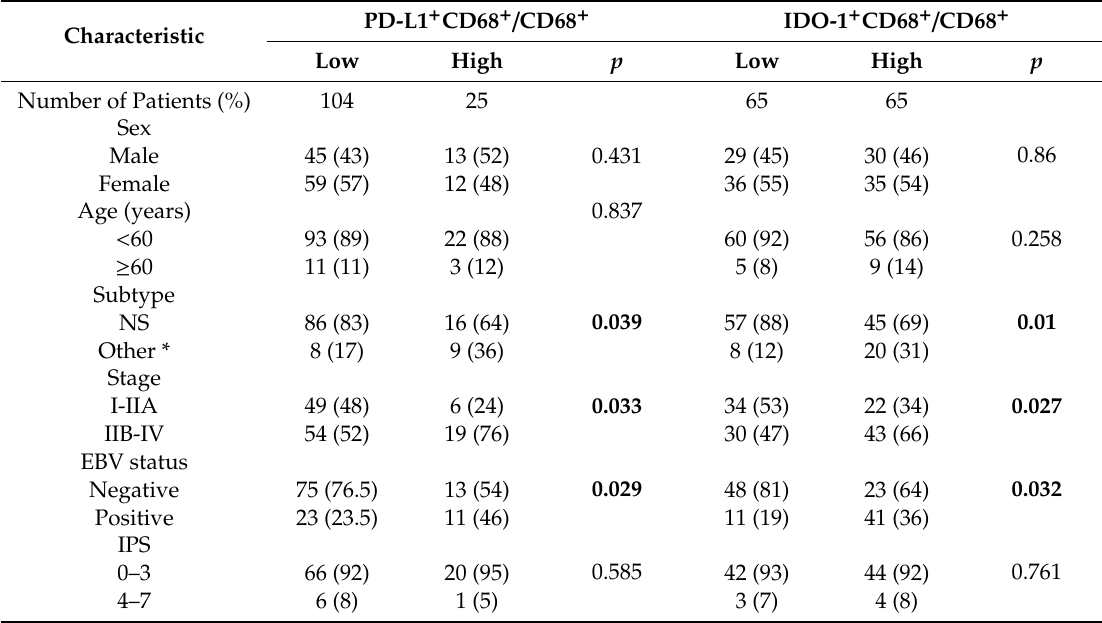
Figure 2. Association of the macrophage immunophenotypes with FFTF. Kaplan–Meier estimates for FFTF according to ( a ) PD ‐ L1 + CD68 + /CD68 + cell ratio (cut ‐ off highest fifth, 50%) and ( b ) IDO ‐ 1 + CD68 + /CD68 + cell ratio (cut ‐ off median, 5.5%) dividing the patients into high and low cell ratio subgroups. Table 4. Distribution of baseline characteristics between high and low cell ratio of PD-L1 + CD68 + / CD68 + and IDO-1 + CD68 + / CD68 +